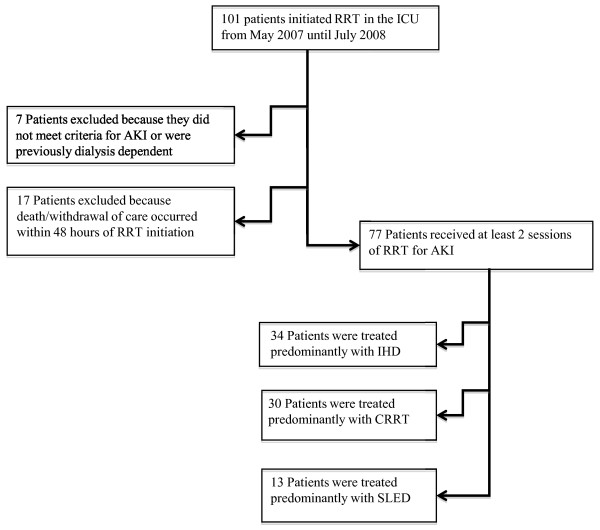
Flow diagram of exclusion and inclusion criteria.